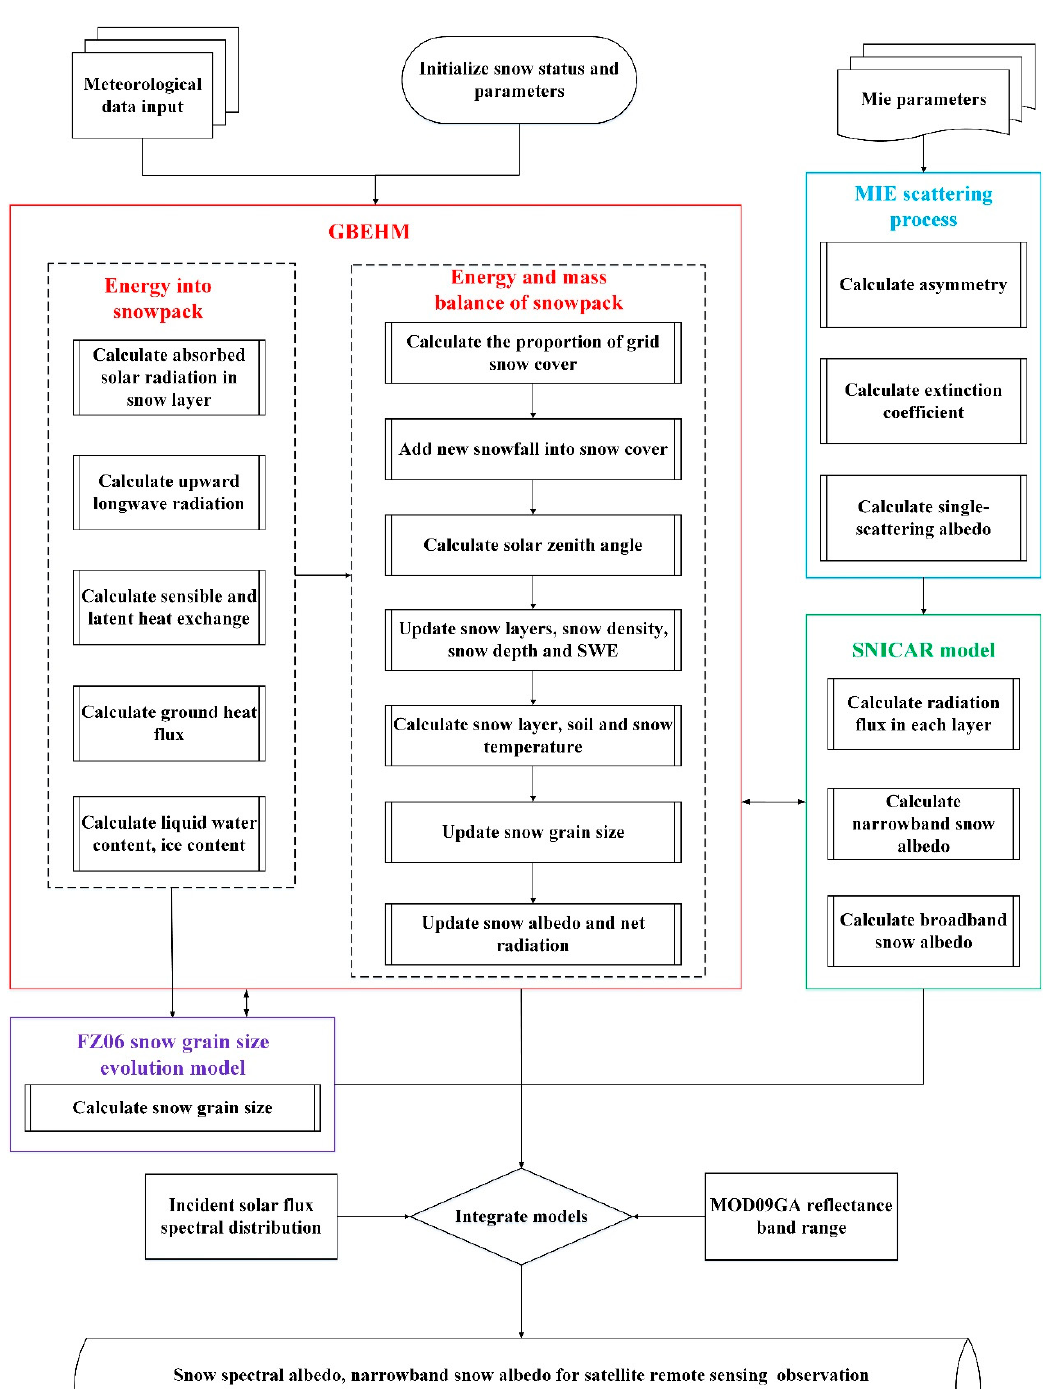
Figure 2. Coupling framework of the integrated model.